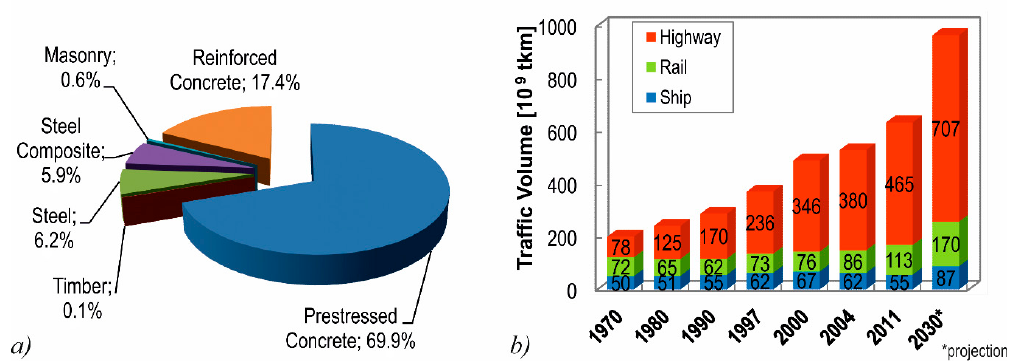
Figure 1. ( a ) German Federal Highway Bridges in terms of bridge deck area [1]; and ( b ) heavy goods traffic volume in Germany [4].